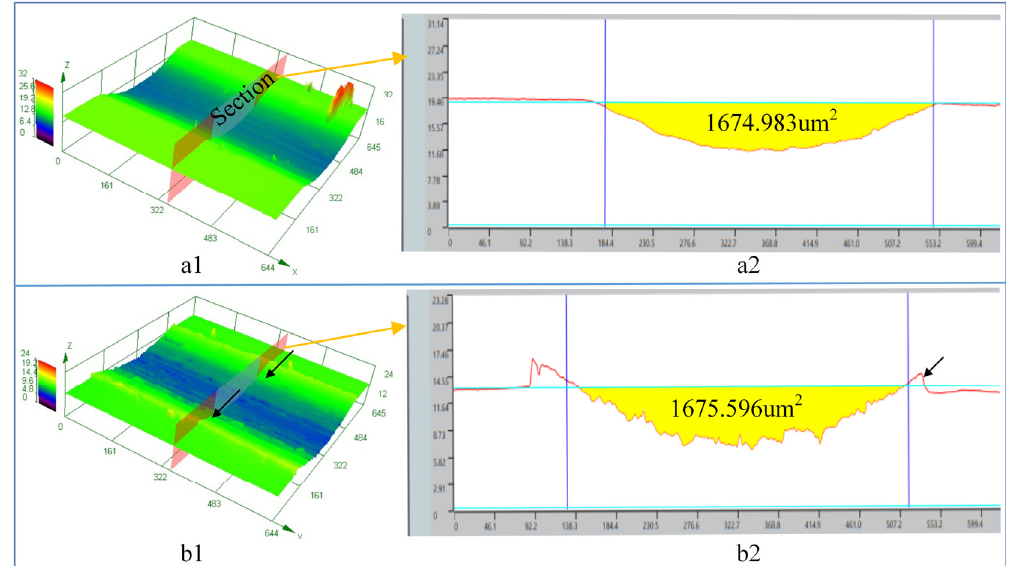
Figure 18. 3D morphologies of wear tracks of ( a1 ) 3D worn surface of Ni60 gear teeth, ( a2 ) corre- sponding section profile in zone a1, ( b1 ) 3D worn surface of 20CrMnTi substrate, ( b2 ) corresponding section profile in zone b1.